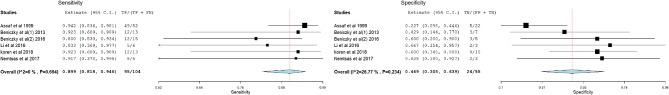
Forest plot showing sensitivity and specificity of the IC-ESI studies (individual studies: size of the squares are proportional to weights used in meta-analysis; the summary measure: center line of the diamond; associated 95% confidence intervals: lateral tips of the squares and the diamond).